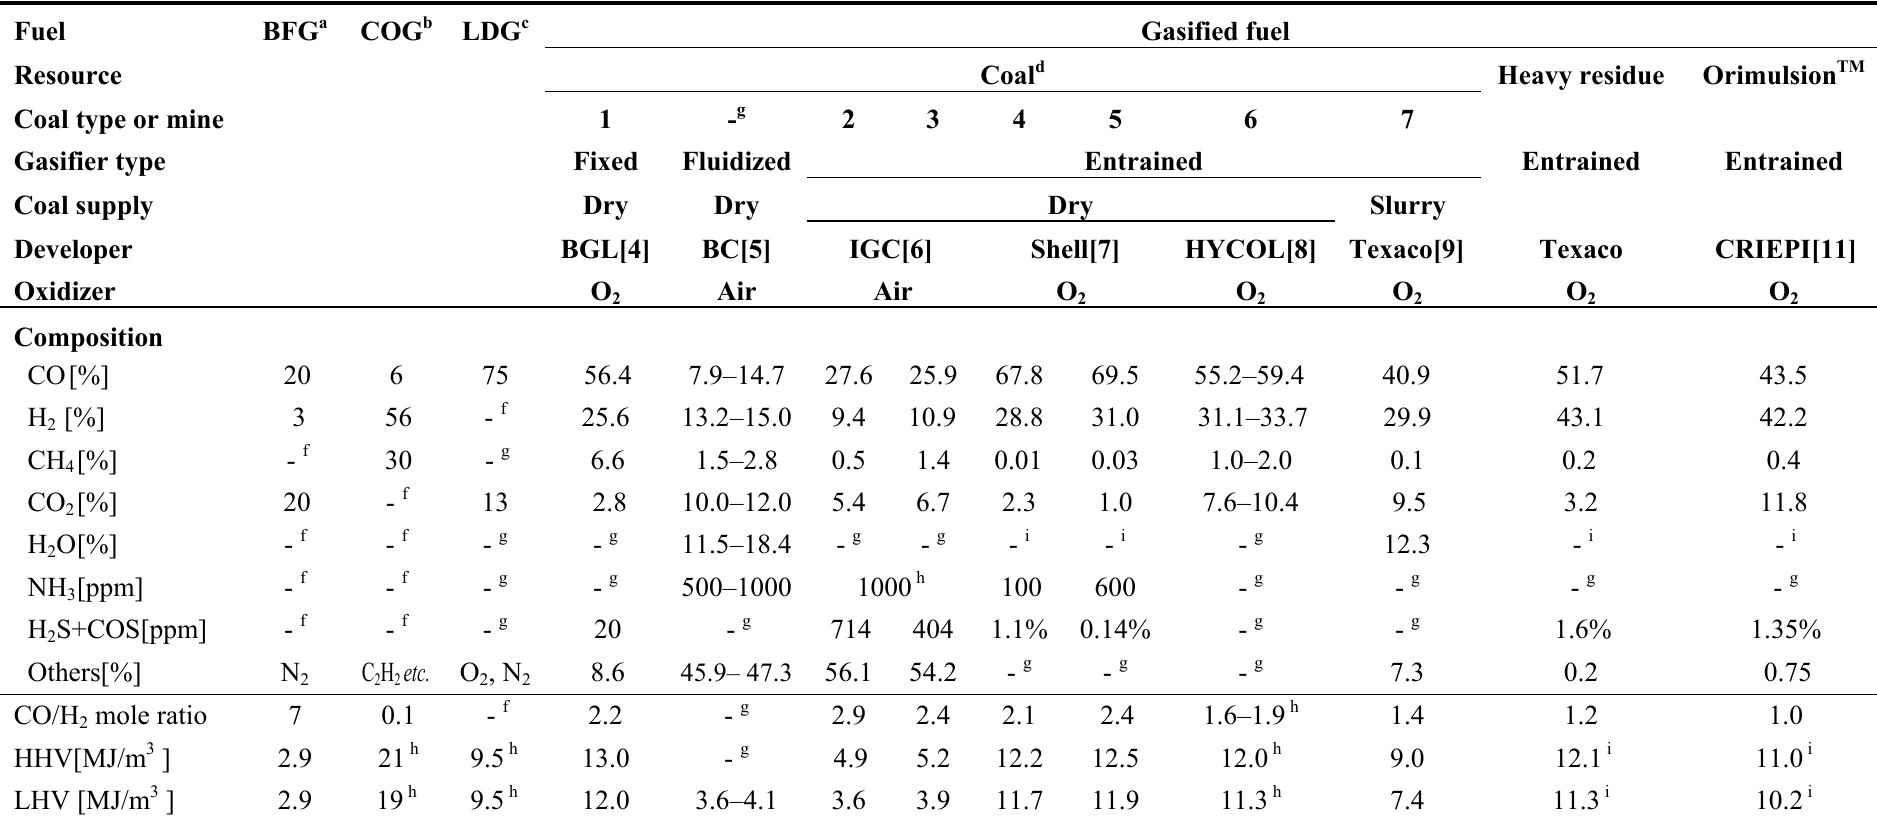
Table 1. Typical compositions of derived gases from fossil-base gasifiers and